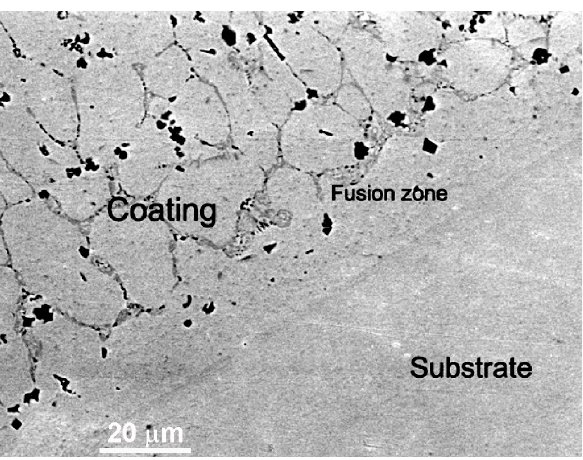
Figure 13. SEM image of the CoCrCuFeNi equimolar HEA coatings reinforced by the TiC and TiB 2 particles. The substrate is a Q235 steel. The fcc matrix in the HEA coating appears light grey, the bcc phase in the GBs appears dark grey. The TiC and TiB 2 particles appear black. Micrograph is reprinted with permission from ref. [42]. Copyright 2021 Elsevier.